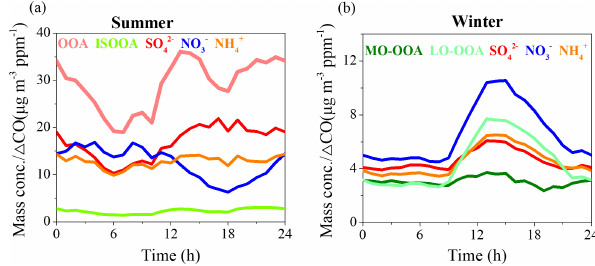
Figure 3. Average diurnal variations in the ratios between sec- ondary species and (cid:49) CO during summer (a) and winter (b)